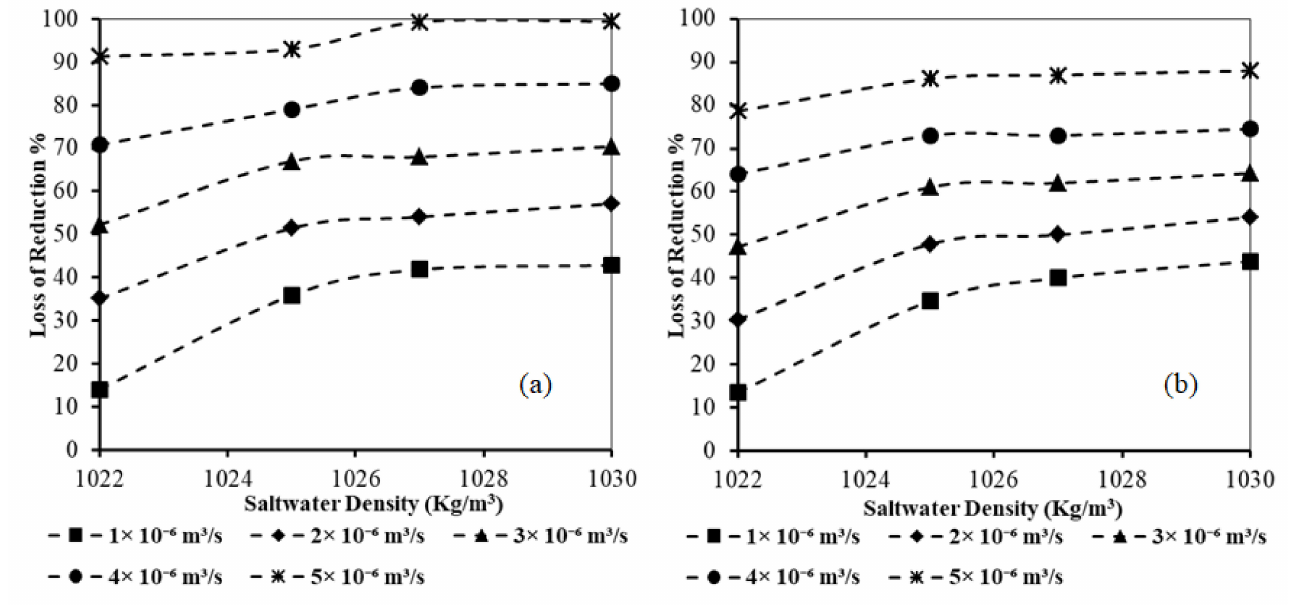
Figure 14. Relation between saltwater density and loss of subsurface dam effectiveness D F = 0.01 m, H f = 0.1 m, and L w /L d = 2.0 for different values of H w /H d : ( a ) 0.25, ( b )